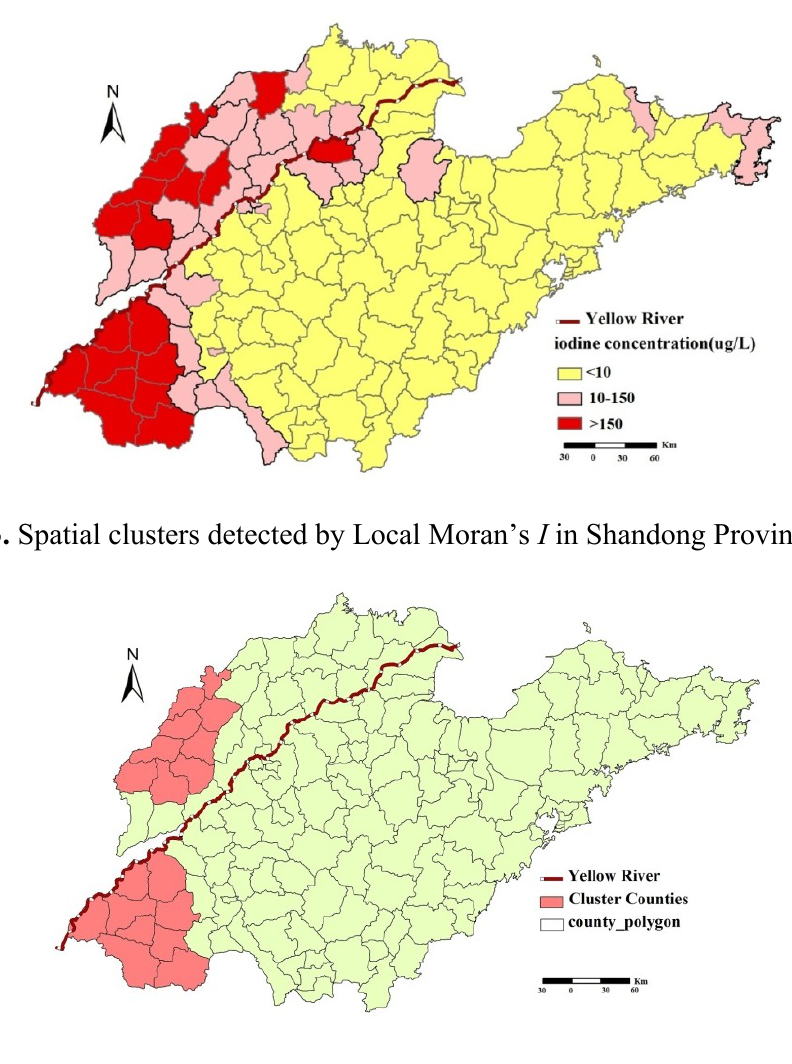
Figure 2. Distribution of iodine in drinking-water in Shandong province, China.